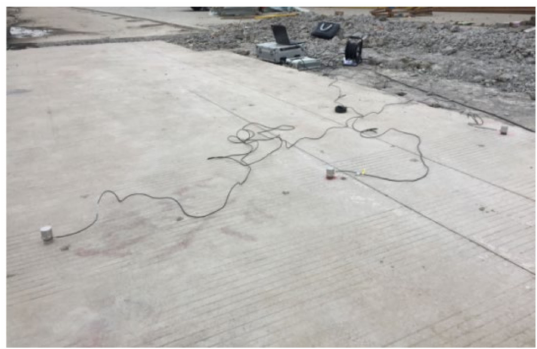
Figure 8. Dynamic test.